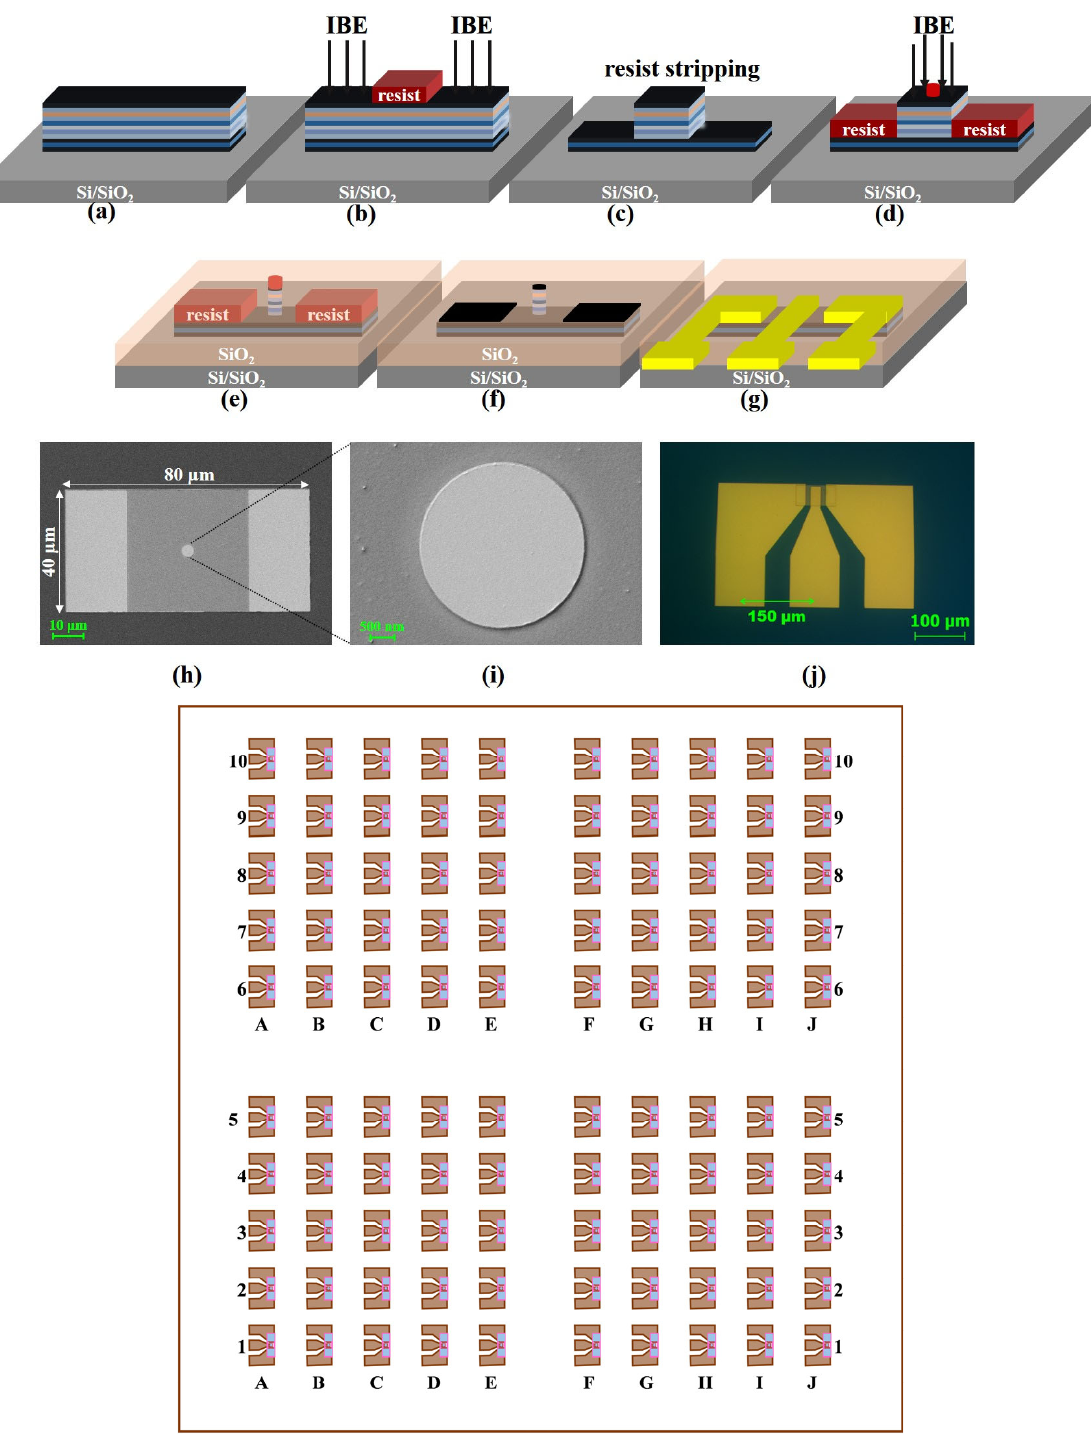
Figure 2. ( a – g ) Schematic representation of the sensor microfabrication process. ( h ) SEM image of the magnetoresistive structure of 40 × 80 µ m 2 and ( i ) pillar detection element. ( j ) Optical microscopy image of the final device with coplanar waveguide geometry of the contacts. ( k ) Schematic representation of a chip with 100 MTJ sensor devices.